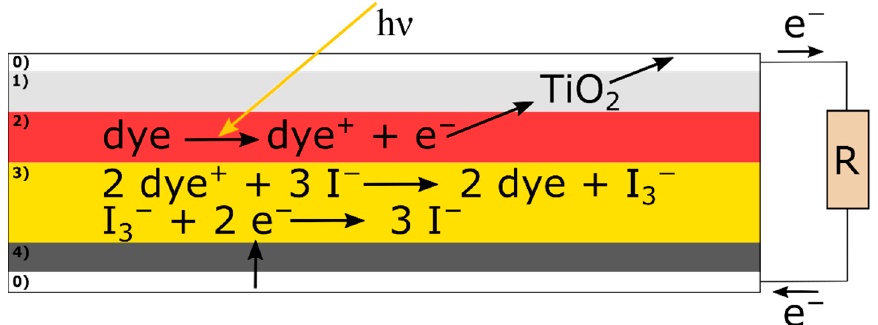
Figure 1. Schematic structure and working principle of a DSSC. The layers labeled 0) represent the conductive glass electrodes. 1) is the TiO 2 layer as first functional layer, 2) depicts the second functional layer, the dye, with the respective reaction, 3) is the electrolyte with the associated reactions of electron transport and 4) is the catalyzer as fourth functional layer.